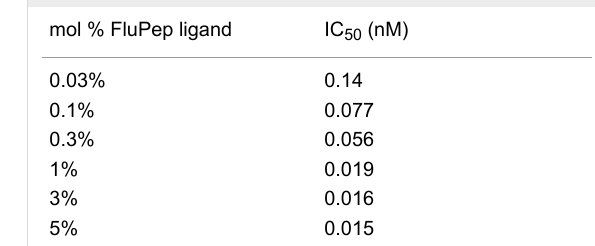
Table 2: IC 50 values of silver nanoparticles functionalised with differ- ent molar fractions of FluPep